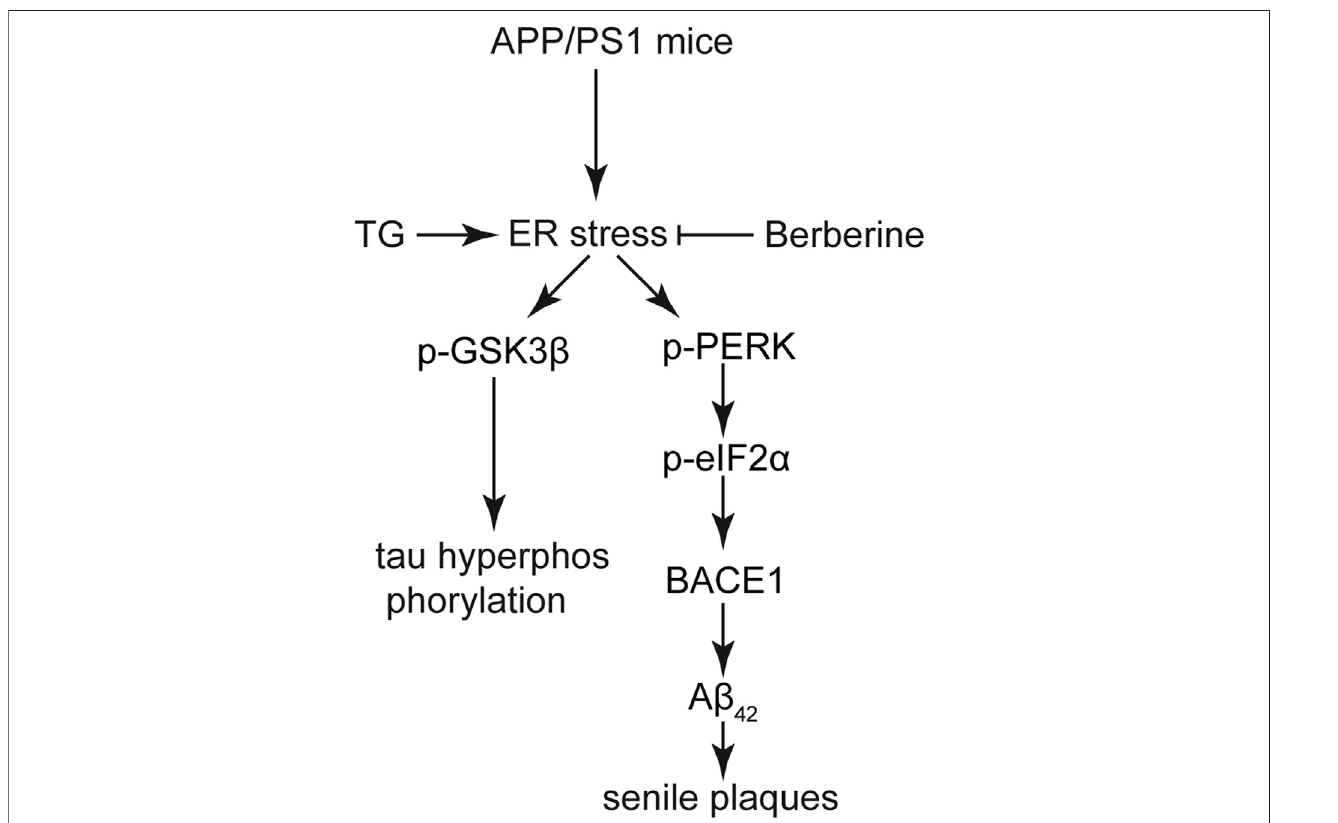
FIGURE8| Afunctionalmodelofberberine-protectingeffectsagainstERstressinducedproductionofsenileplaquesandhyperphosphorylationoftauinAD.Inthe APP/PS1 AD model, ER stress was induced, and subsequently activated GSK3 β cascade and the PERK/eIF2 α /BACE1 signaling pathway. Tau hyperphosphorylation and A β 42 deposition were attenuated by BBR, which is mainly attributed to its ability to suppress ER stress in the AD model.